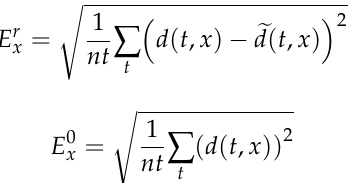
Figure 3. The curves of the reconstruction errors of (a) surface waves and (b) reflections against the threshold amplitude. LRT: linear Radon transform; HRT: hyperbolic Radon transform.